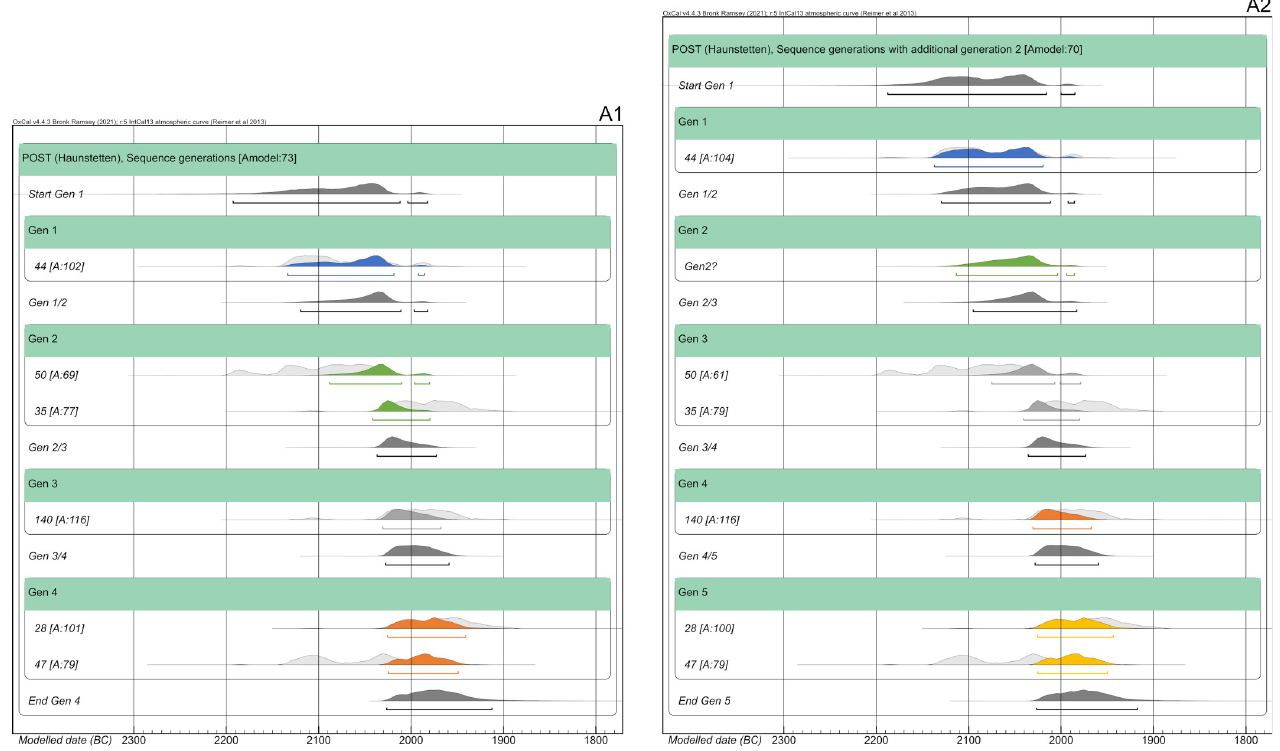
Fig 20. Bayesian modelling of the right strand of the pedigree of POST from sequencing the generations. (light grey) unmodelled probabilities; (coloured) modelled probabilities. (A1) Model with individual POST_44 being the uncle of POST_50. (A2) Model with POST_44 being the grandfather of POST_50 (see S6 Table Sheet 5 and